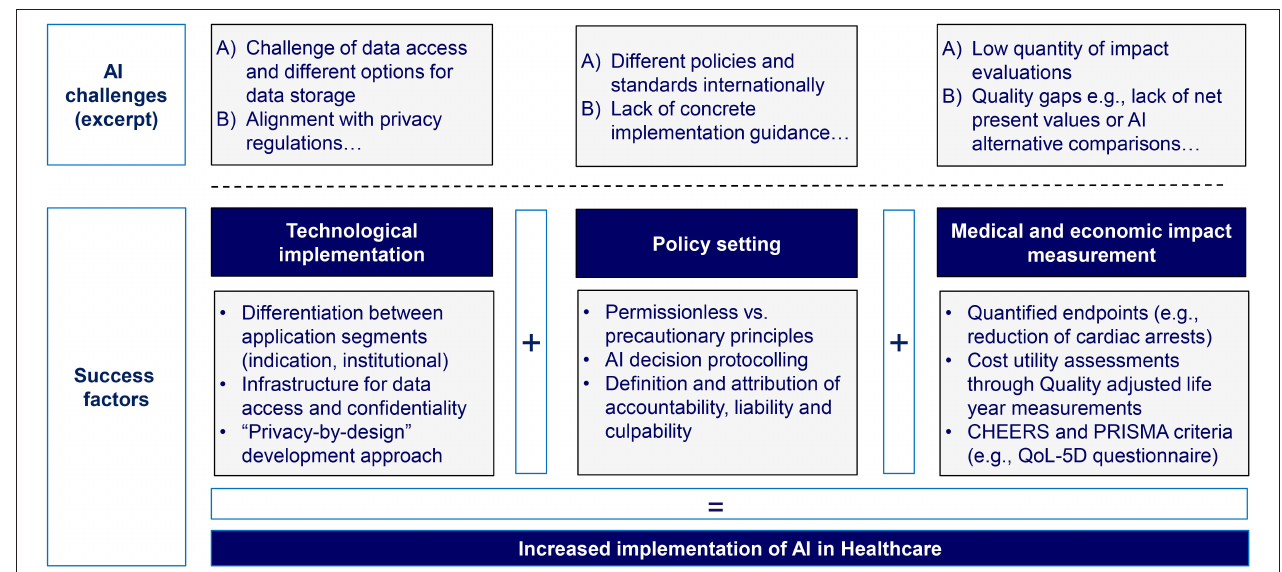
FIGURE 7 | Overview of success factors facilitating the implementation of AI in healthcare (authors).